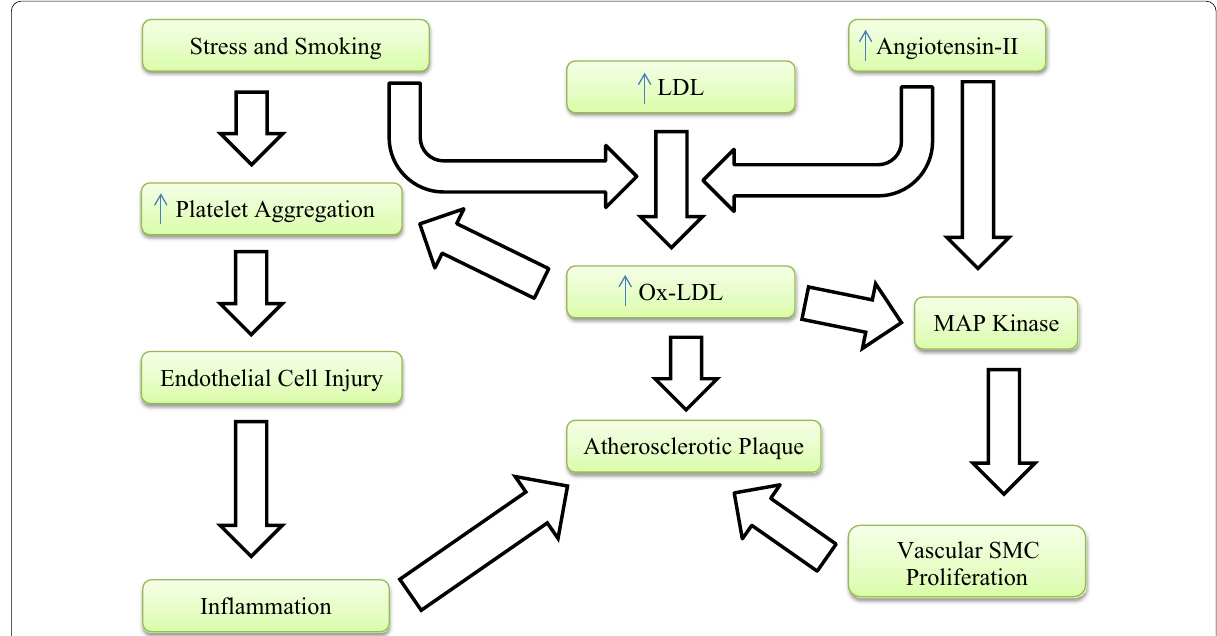
Fig. 1 Schematic design depicting the involvement of oxidized low density lipoprotein (oxLDL), injury of endothelial cells and proliferation of vascular smooth muscle cells (SMC) in the development of atherosclerotic plaque. MAP Mitogen-activated